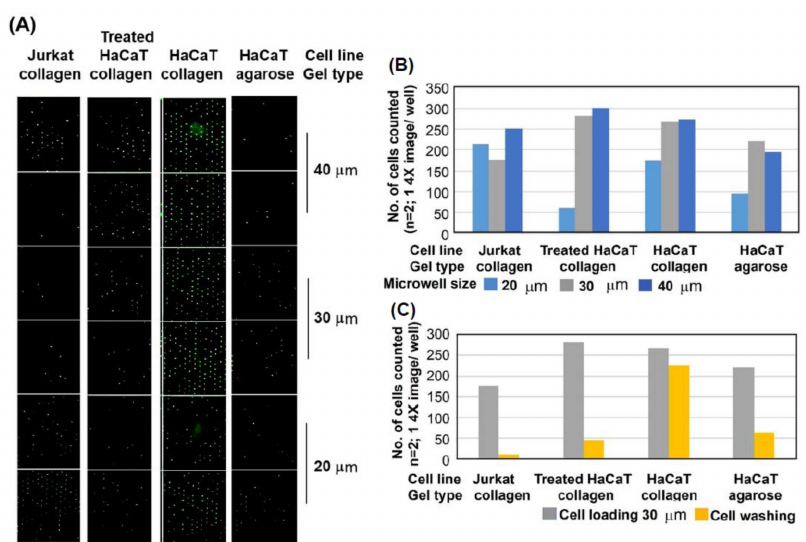
Figure 3. Loading study with 20–30–40 µ m wells ( A , B ) and washing study using 30 µ m pores ( C ). Jurkat cells are smaller and load well into 20, 30 and 40 µ m pores, whereas HaCaT keratinocytes, expressing β 1 integrin, are larger and load best into 30 and 40 µ m wells. One wash is insufficient ( B ), but a second wash in 30 µ m wells ( C ) shows that Jurkat cells do not bind to collagen I in the agarose microwells and are washed out, while HaCaT cells bind to collagen I in the microwells even after washing but are washed out if collagen I is omitted (“HaCaT agarose”) or if HaCaT cells are over-trypsinized to remove β 1 integrin (“treated HaCaT collagen”), preventing binding to collagen I. ( C ) Corresponding CometChip graphs of ( A